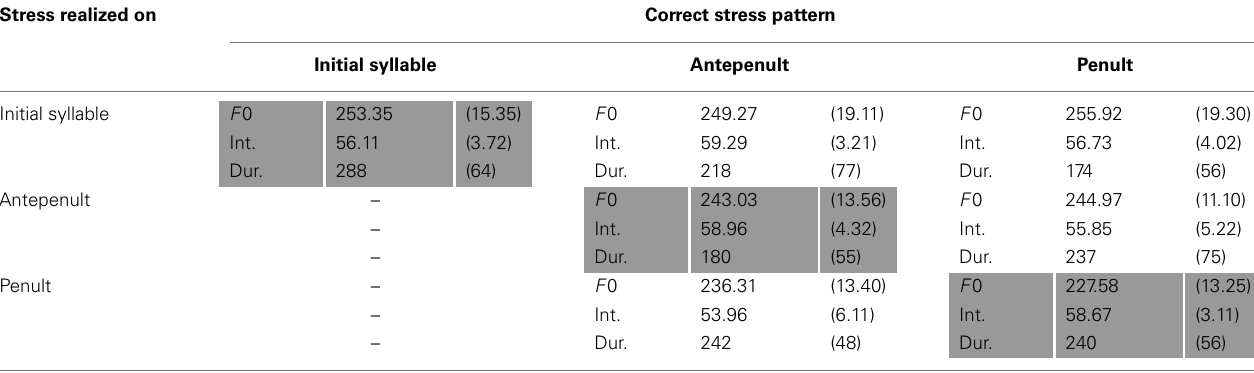
Table 2 | Descriptive statistics of phonetic